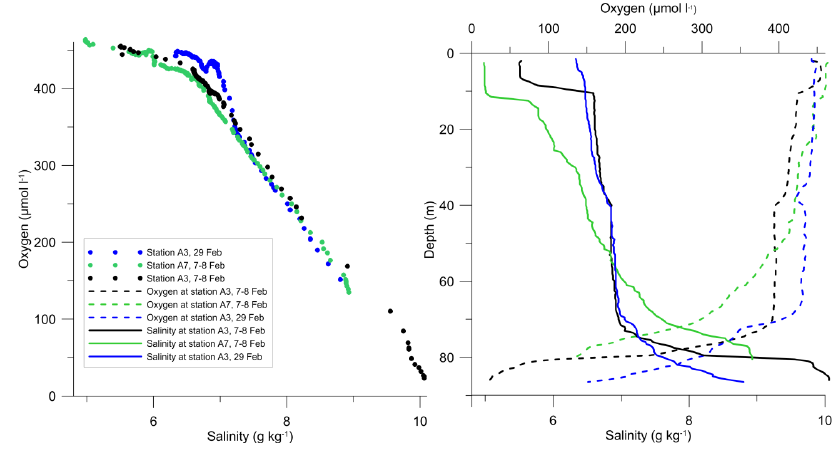
Figure 9. Oxygen-salinity diagrams (dots on left panel) and salinity (g kg –1 , solid lines on right panel) and dissolved oxygen (µmol l –1 , dashed lines on right panel) profiles on 7–8 February (black) and 29 February (blue) at station A3 and on 7–8 February (green) at station A7.